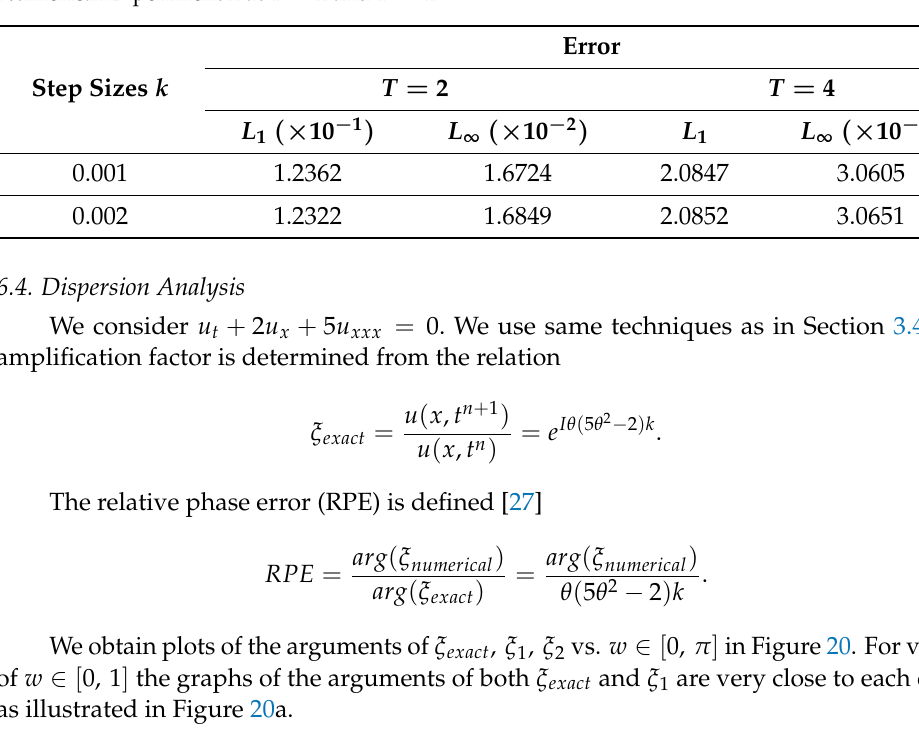
Figure 19. Plot of the absolute error vs. x using Scheme 1 for Numerical Experiment 2. The spatial and temporal step sizes are h = π /10 and k = 0.001, respectively. Table 4. L 1 and L ∞ errors for various k when h = π /10 when Scheme 1 is employed to approximate Numerical Experiment 2 at T = 2 and T =